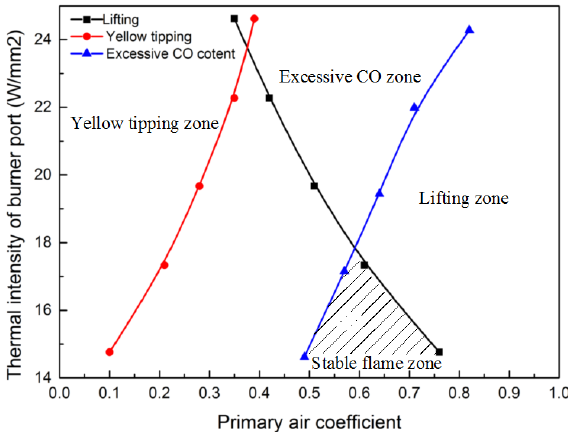
Figure 10. Flame stability diagram for the comparative gas. Table 8. Testing data of CO content in the flue gas of the comparative gas.